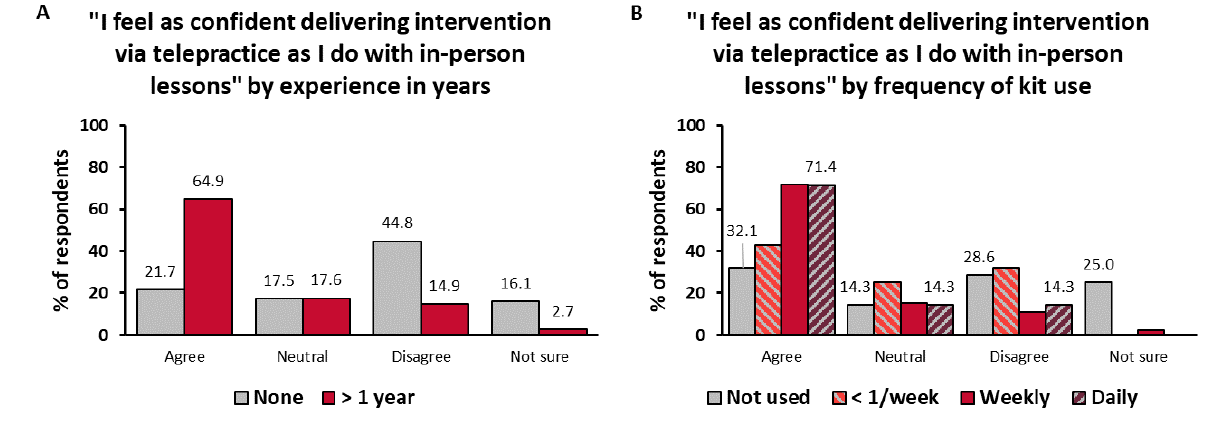
Note. Figure 2.A: Confidence with telepractice delivery according to clinician’s experience in telepractice (gray: no experience, n = 143; red: more than 1 year of experience, n = 74); Figure 2.B: Confidence with telepractice delivery after 4 weeks according to the frequency of the MED-EL Remote Lesson Kit use, (gray: not used, n = 28; light red, striped: less than once per week, n = 28; red: weekly, n = 46; dark red, striped: daily, n =